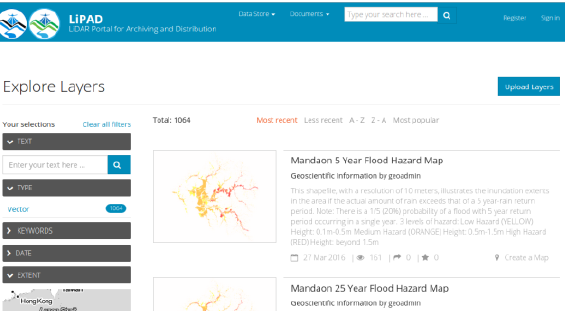
Figure 5. Flood Hazard Layers available in LiPAD